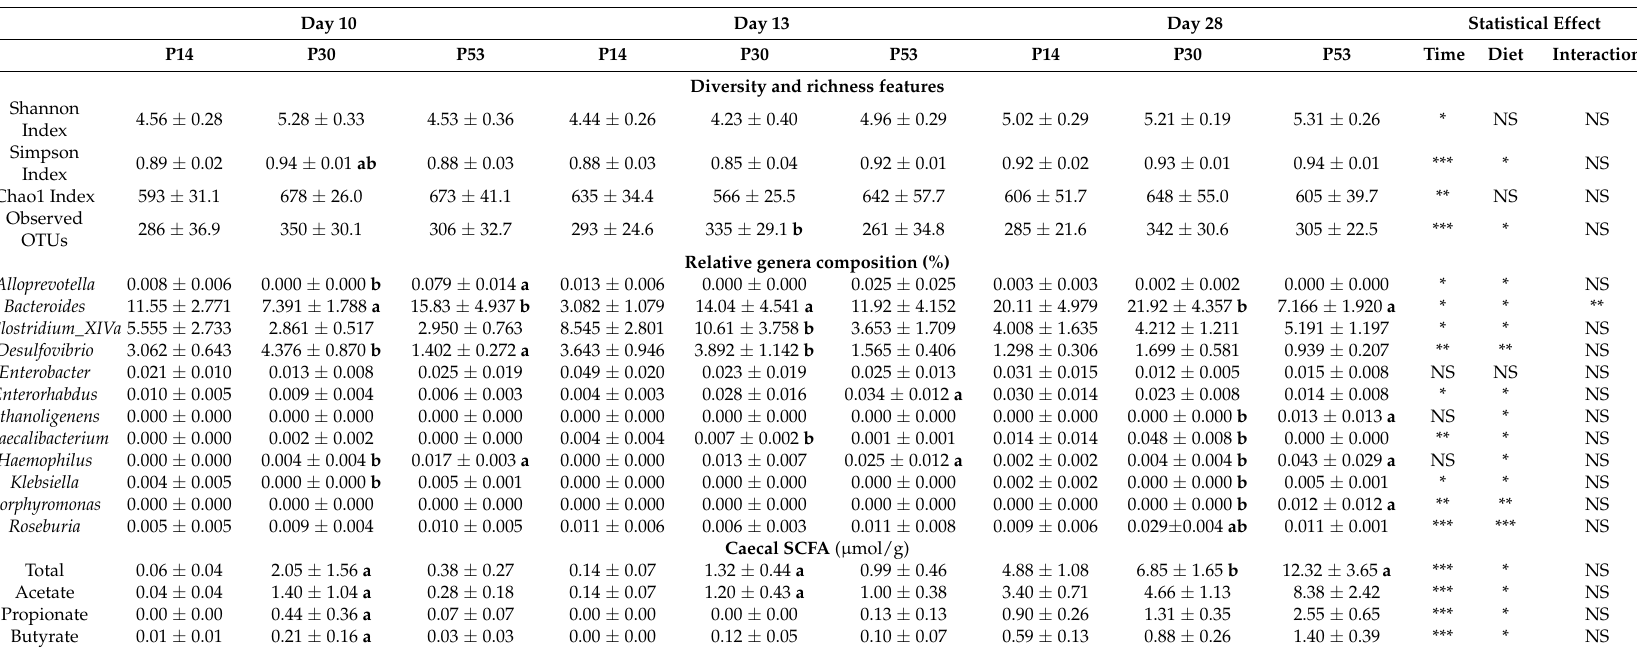
Table 3. Effects of dietary protein intake level on characteristics of mucosal-adherent microbiota. Values are means ± SEM ( n = 10–12). *: p < 0.05; **: p < 0.01; ***: p < 0.001; NS: non-significant difference. a: vs P14, p < 0.05 at the same time, b: vs P53, p < 0.05 at the same